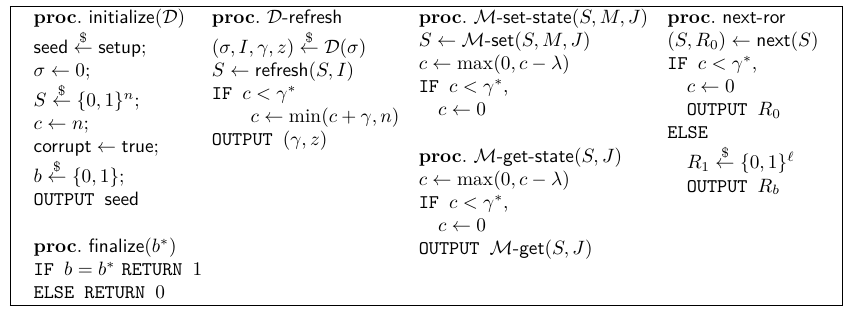
Figure 23: Procedures in Security Game MROB ( γ ∗ , λ